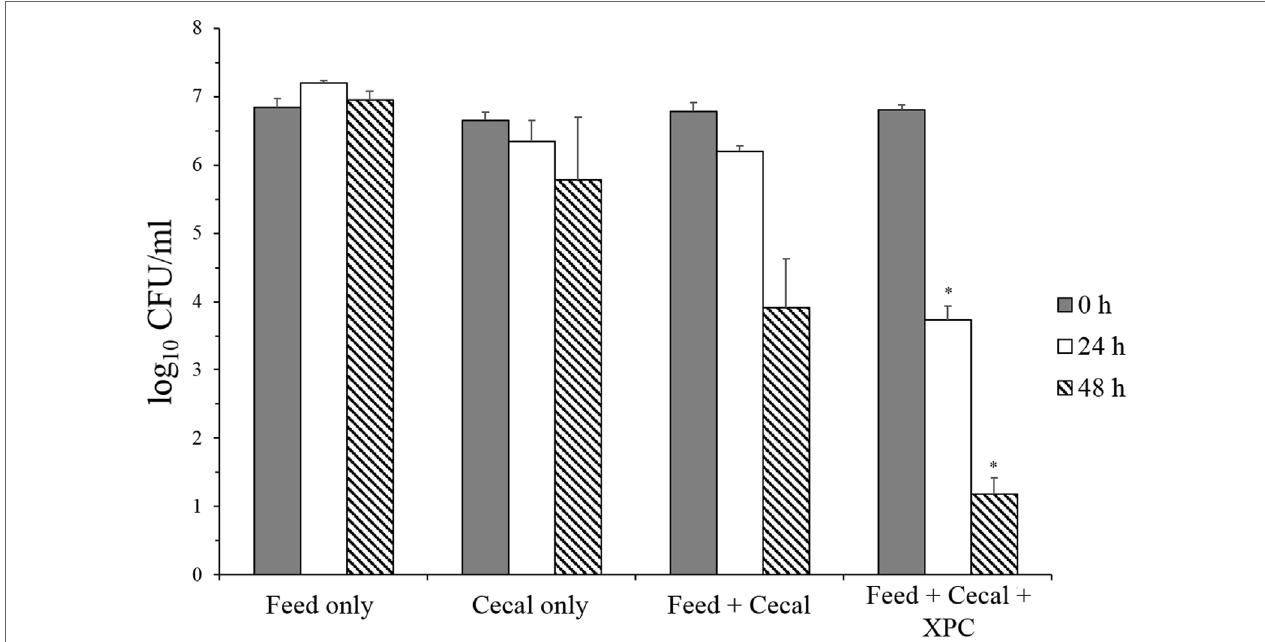
FigUre 3 | Salmonella Typhimurium survival in adapted anaerobic cultures (group 2) with and without fermentation metabolites of Original XPc . Bars and brackets represent the mean and SE of three biological replicates. Asterisks indicate significant difference (P < 0.05) from the “feed + cecal”